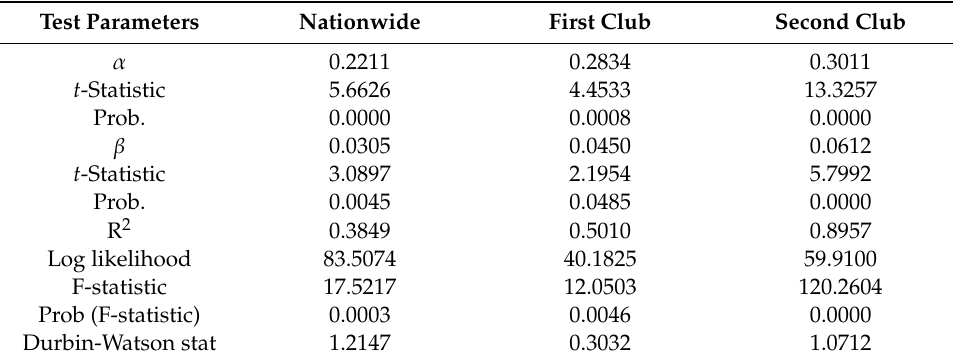
Table 5. Results of regional convergence test in clubs.